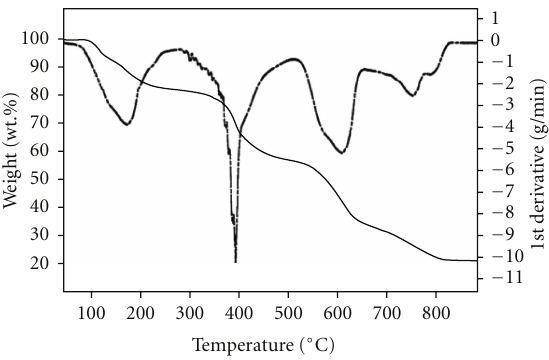
Figure 7: Thermographs of the Co(II) complex of L I H (C 2 ).